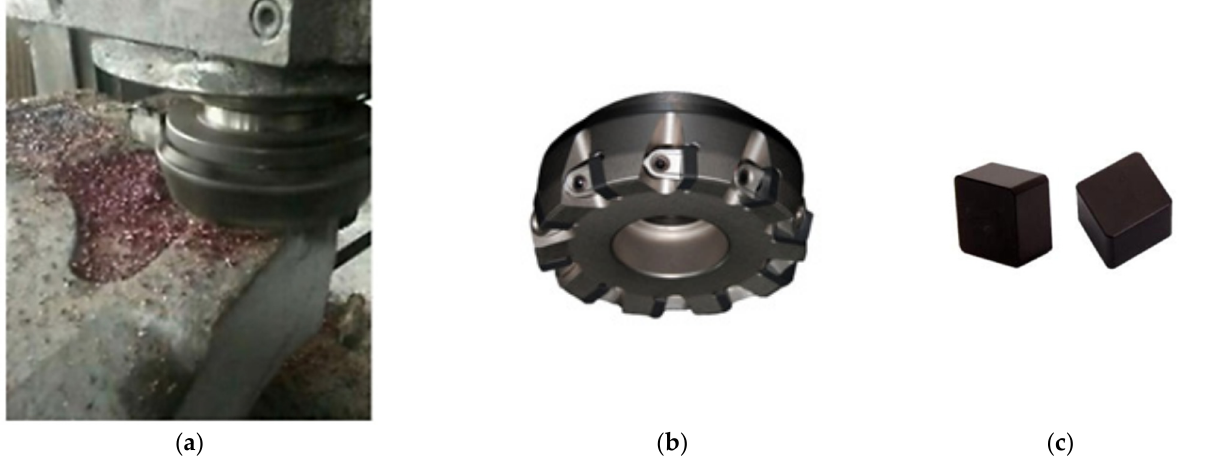
Figure 2. Application of CBN inserts: ( a ) milling process, ( b ) milling head, ( c ) CBN cutting inserts [24].